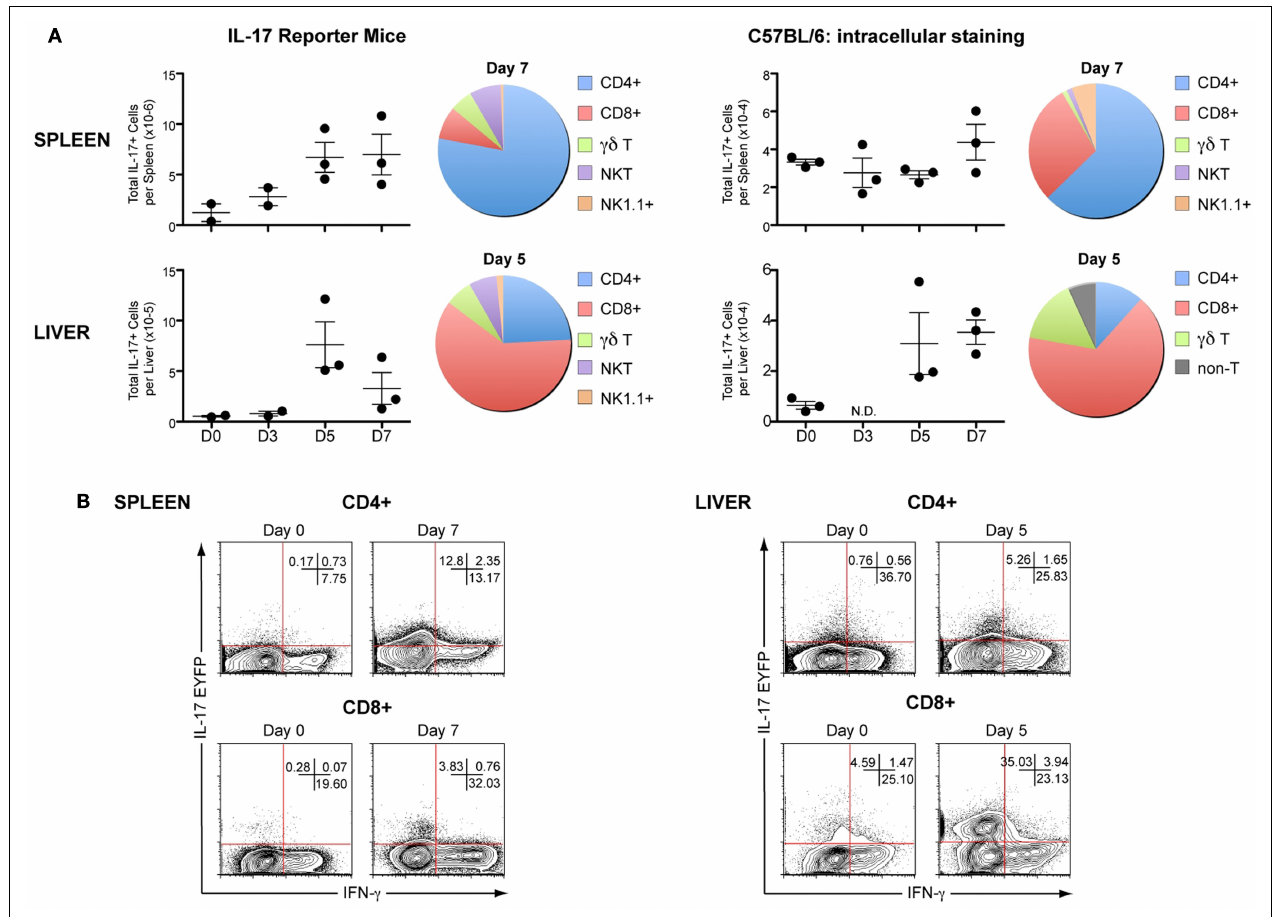
fraction of CD4 + , CD8 + , γδ + , NKT cells, and NK cells contributing to IL-17A + production in spleen and liver at day 7 and 5, respectively. (B) Representative flow cytometry plots of IL-17A eYFP versus IFN- γ expression in CD4 + and CD8 + T cells, in liver cells, and splenocytes of naïve and day 5 and 7 infected mice. Numbers in quadrants refer to the percentages of cells in each quadrant. Data are representative of two experiments and are obtained in groups of three mice per time points (mean ±